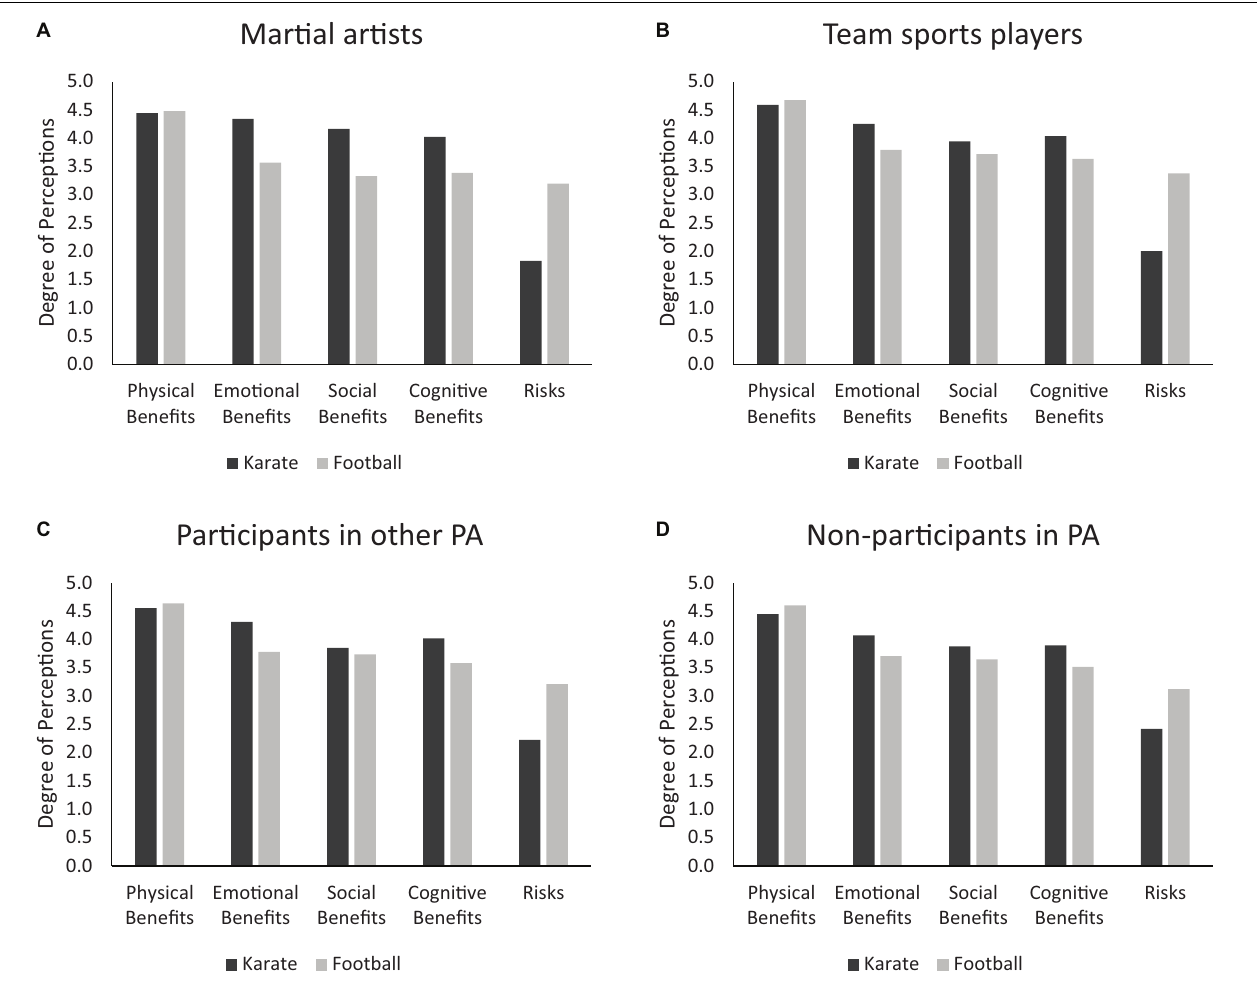
FIGURE 1 | Illustration of the perceptions × sport × type of PA participation interaction. Each panel depicts karate and football perceptions for different types of PA participants: (A) martial artists, (B) team sport players, (C) participants in other PA, and (D) non-participants in